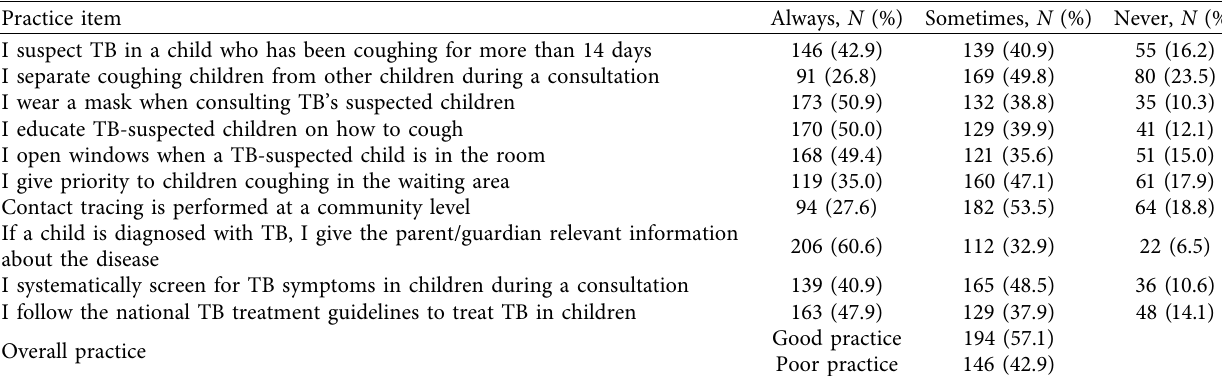
Table 4: Practices of HCWs on pediatric TB management.